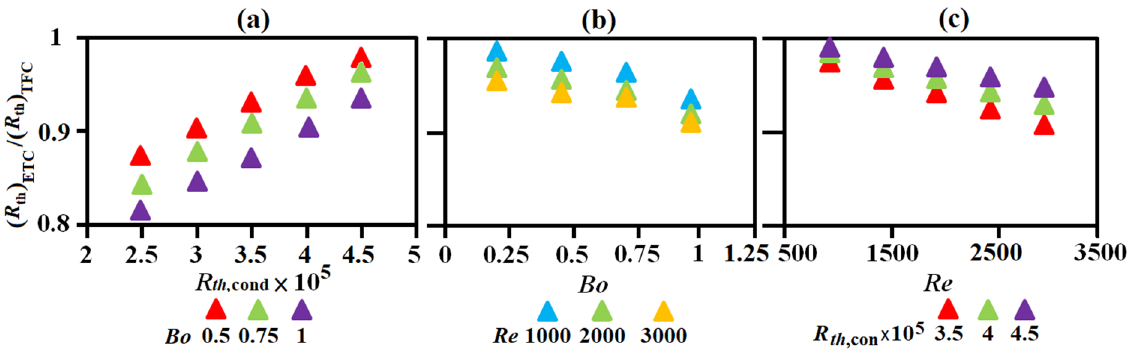
Figure 9. The ratio of R th between the loops with ETC and TFC against ( a ) Re , ( b ) Bo , ( c ) R th ,con